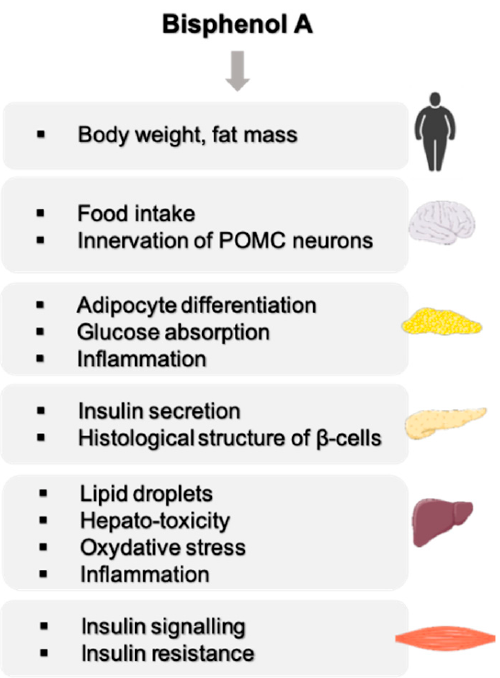
Figure 1. Overview of BPA effects on energy metabolism.